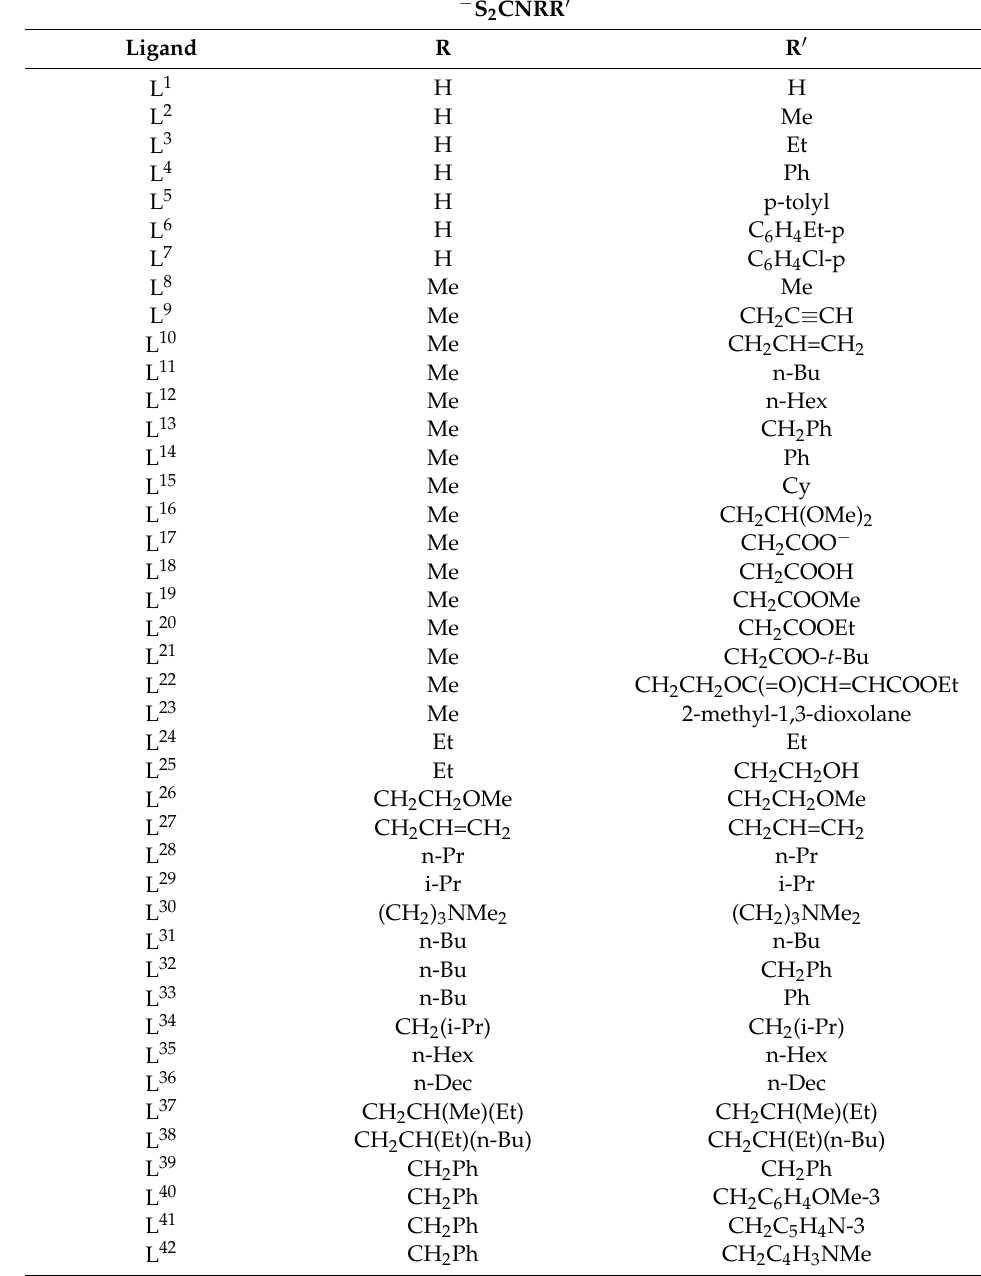
Table 1. List of dithiocarbamates L 1 to L 56